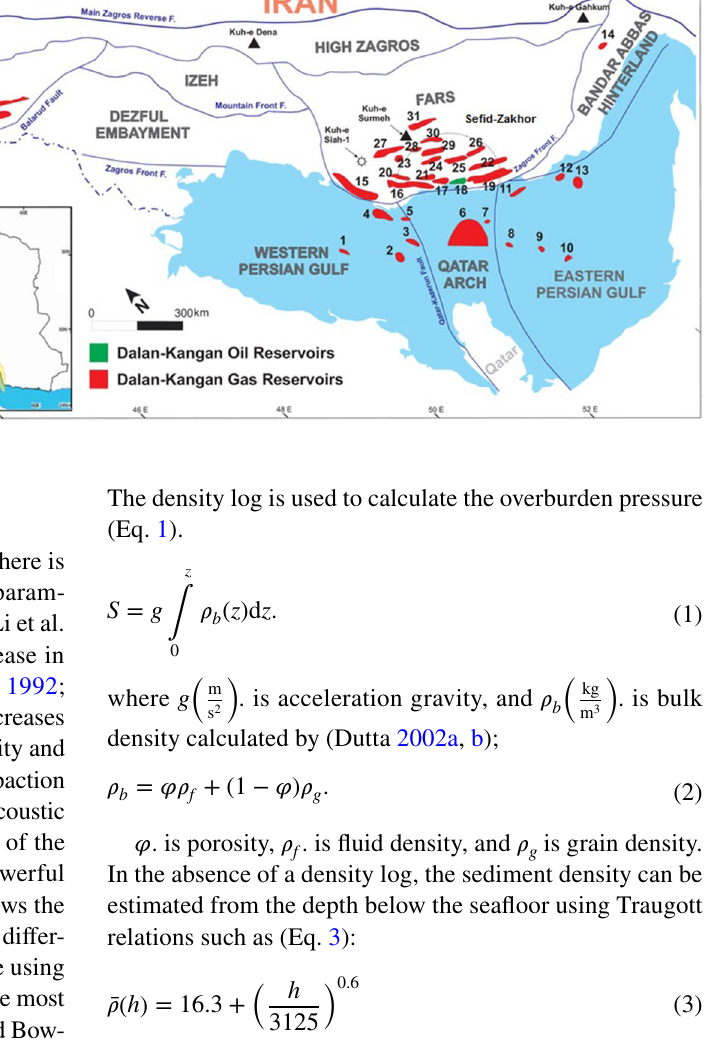
Fig. 1 Sefid-Zakhor geographi- cal location (Abtahi